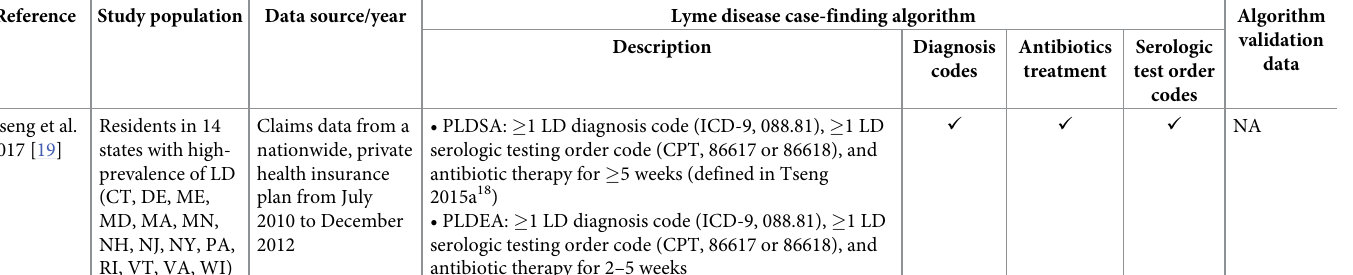
S3 Table. Articles identified through PubMed and Embase search using prespecified search terms for US healthcare claims-based Lyme disease case-finding algorithms published in English since